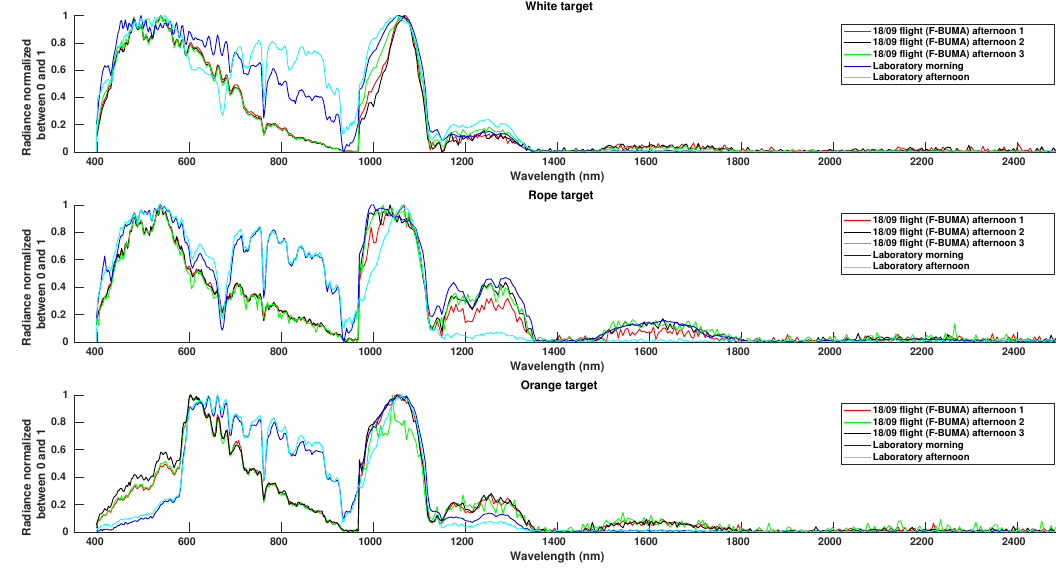
Figure A2. Results for the 18/9 F-BUMA afternoon flight, analyzing 3 different pixels (bright pixel-afternoon 1, a medium pixel-afternoon 2 and a dark pixel-afternoon 3) for each material, and comparing them to the laboratory